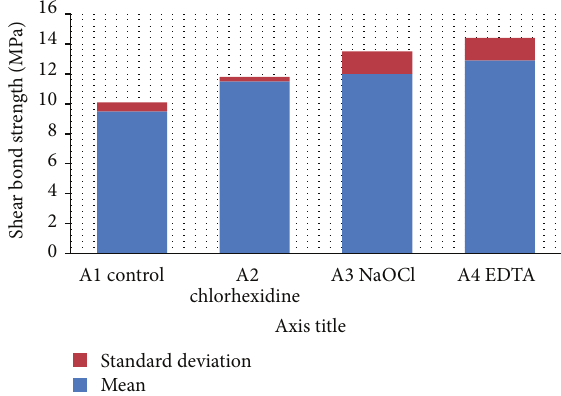
Figure 3: The effect of different surface pretreatments on the mean shear bond strength